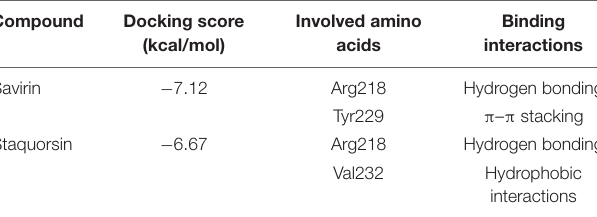
inhibition data as savirin can inhibit two types of cytochrome P450 while staquorsin inhibit only one type. A summary of this comparison is presented in Table 2